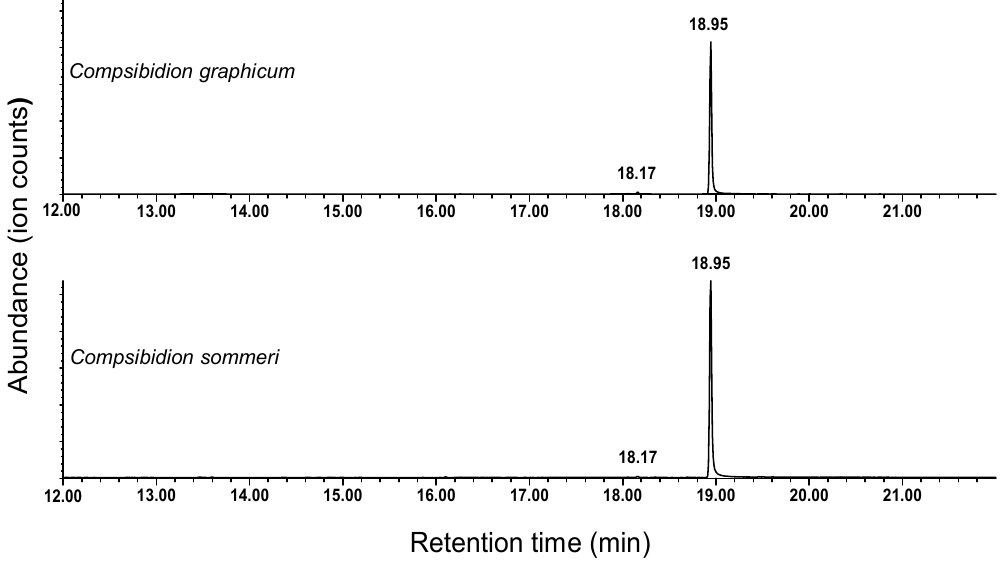
Figure 4. Representative total ion chromatograms of extracts of headspace odors from adult males of Compsibidion graphicum and Compsibidion sommeri . The male-specific peaks at 18.17 min (10-methyldodecanal) and 18.95 min (10-methyldodecanol) were not present in equivalent extracts from females or system controls.